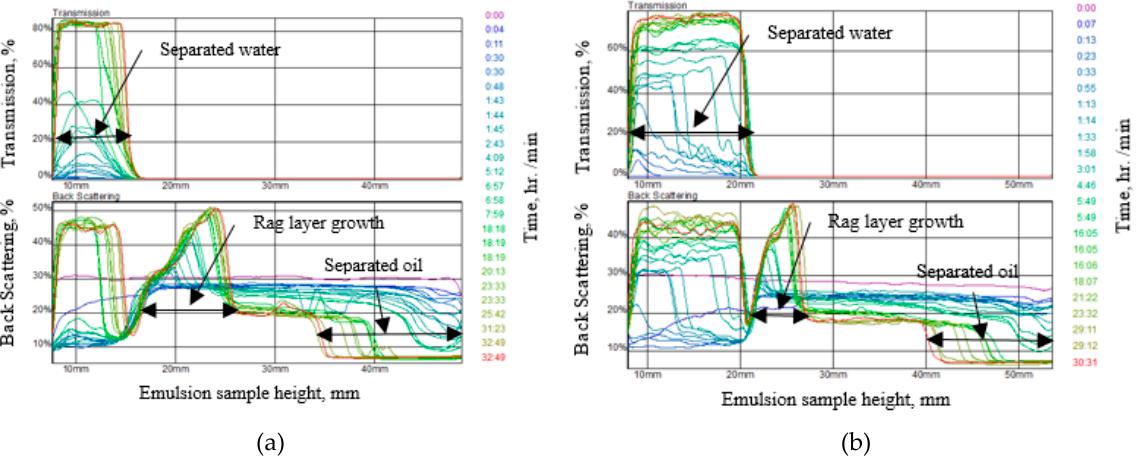
Figure 10. Emulsion as a function of the polymer. ( a ) Low polymer; ASP (ppm) = 1000, 400, 400. ( b ) High polymer; ASP (ppm) = 1000, 400, 600. The dark and light blue color lines shows the initial measurement of emulsion stability values; red & yellow color lines shows final stability measurement values. Table 8. Alkali–surfactant–polymer concentration for Turbiscan test/stability